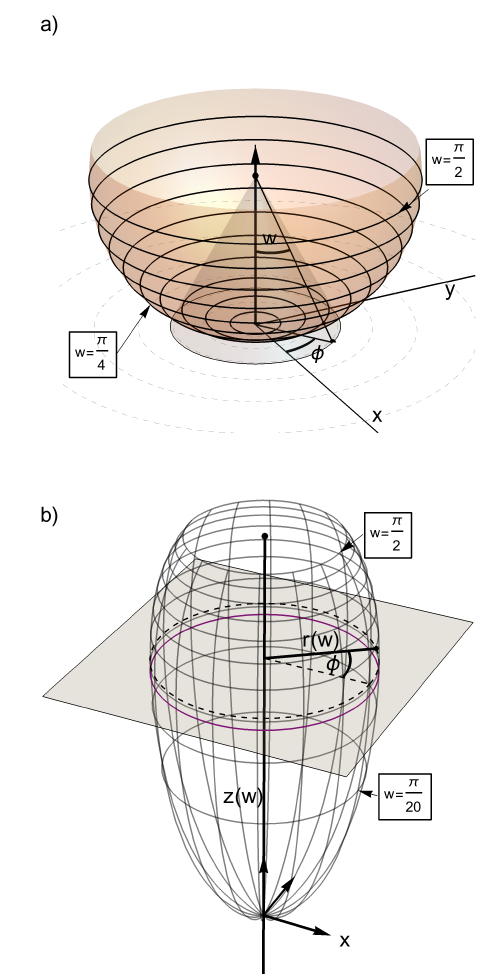
Figure 1. ( a ) representation of the visual field hemisphere, S 2 , expressed in spherical-polar coordinates ( w , φ ). The visual axis , having w = 0, is aligned with the z -axis, but it extends downward from the eye fovea position at ( 0,0,1 ) , represented by the ‘visible’ dot at the center of S 2 . The eccentricity, w , is the colatitude referred to the visual axis, rather than the positive z -axis. The azimuthal angle, φ , spans the ( 0,2 π ) range counter-clockwise around the positive z -axis. Ten parallel latitudinal circles are shown, separated by equal π increments of w from 0 to π . Parallels are ‘geodetic circles’ but not geodetic 20 2 curves, except for the equatorial great circle at π ; ( b ) representation of the primary visual cortex, 2 V 1, in cylindrical coordinates ( r ( w ) , φ , z ( w ) ). Surface parametrization is still made in terms of the eccentricity w and azimuthal angle φ in the visual field. However, the cortical location corresponding to the eye fovea is now set at the ( 0,0,0 ) origin of cortical space, and the visual axis, still having w = 0, now coincides precisely with the positive z -axis of axial symmetry in V 1. Ten parallel latitudinal circles are shown, separated by equal π increments of w from 0 to π . Parallels are ‘geodetic circles’ centered at 20 2 the z = 0 foveal origin in V 1. Those parallels are not geodetic curves, however, except for the maximal equatorial parallel, colored in purple. The CMF has the form given in Equation (30) with parameter values of A = 525.6 in units of millimeters and B = 33.48 in units of inverse radians